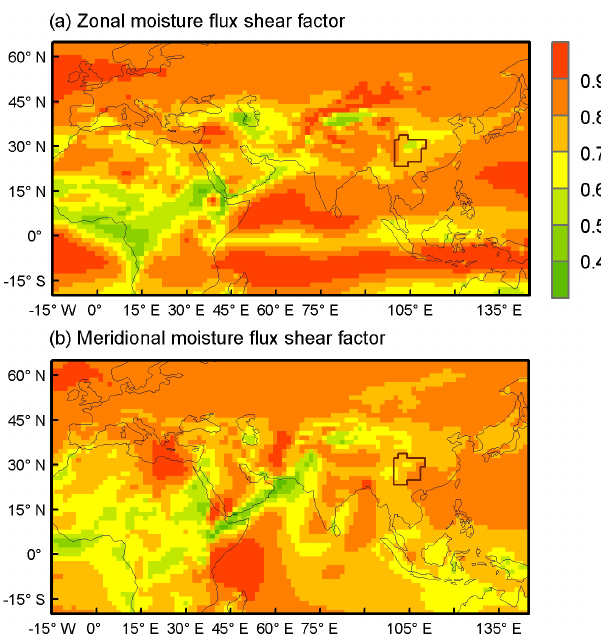
Figure 8. Horizontal moisture flux shear factor in JAS averaged over 1979–2013 with ERA-I. (a) Zonal moisture flux shear factor and (b) meridional moisture flux shear factor.